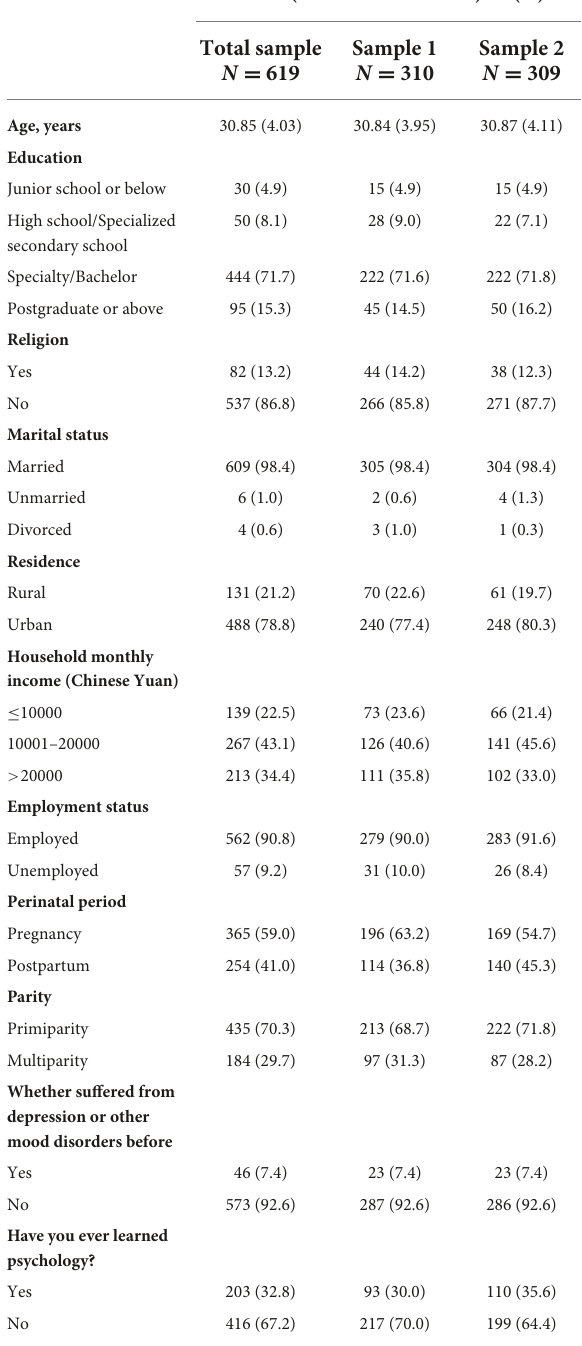
TABLE 1 Characteristics of the included